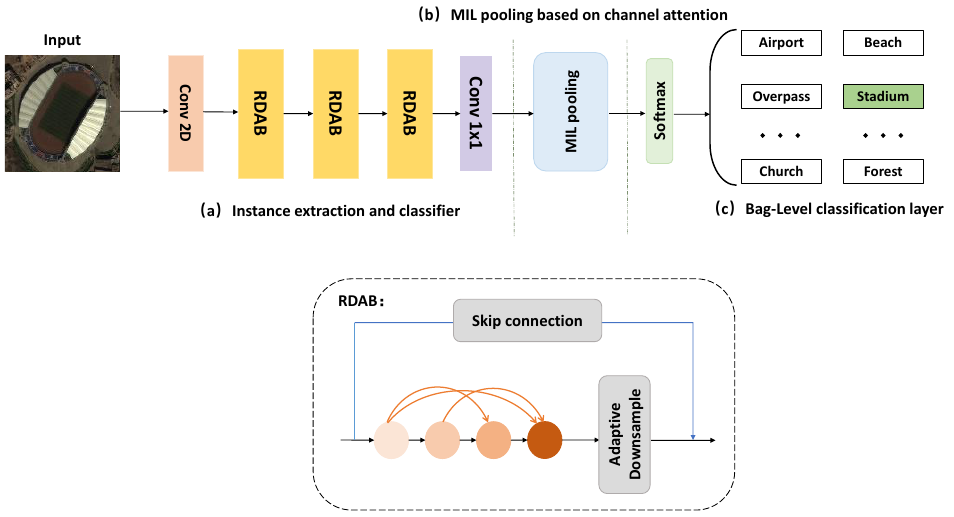
Figure 3. Overall structure of the proposed MILRDA model. The model consists of three parts: ( a ) instance extraction and classifer, ( b ) MIL pooling based on channel attention and ( c ) bag-level classification